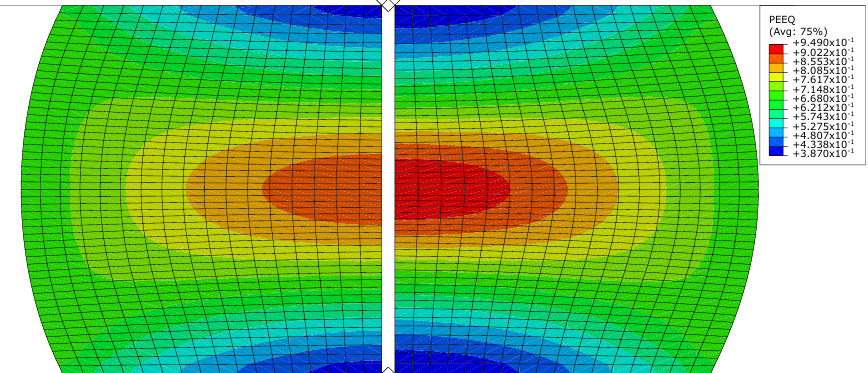
Figure 8. Equivalent plastic strain ε p contourplot for the compression of a cylinder using the 3-7-4-1 ( left side ) and the 3-15-7-1 ( right side ) ANN flow laws.